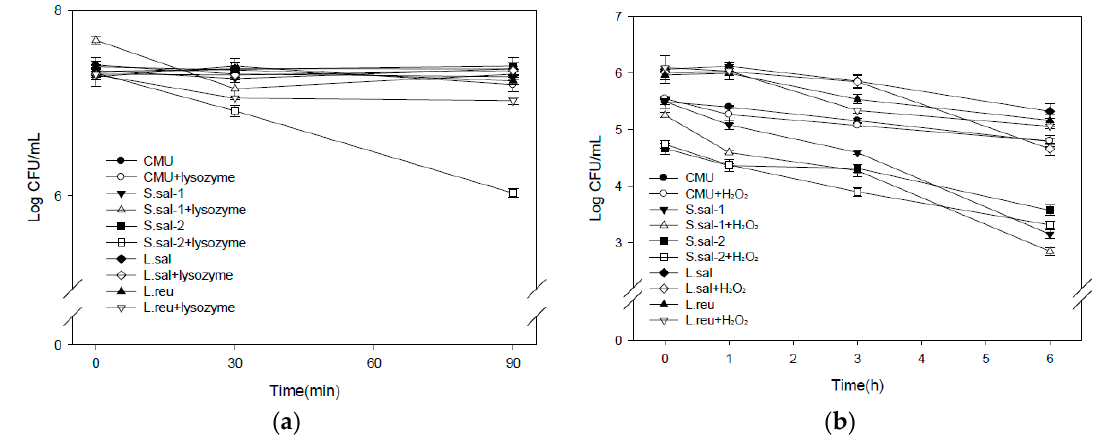
Figure 1. The survival level of oral probiotic strains after treatment with ( a ) 0.01% lysozyme ( w / v ), and ( b ) 1 mM hydrogen peroxide.